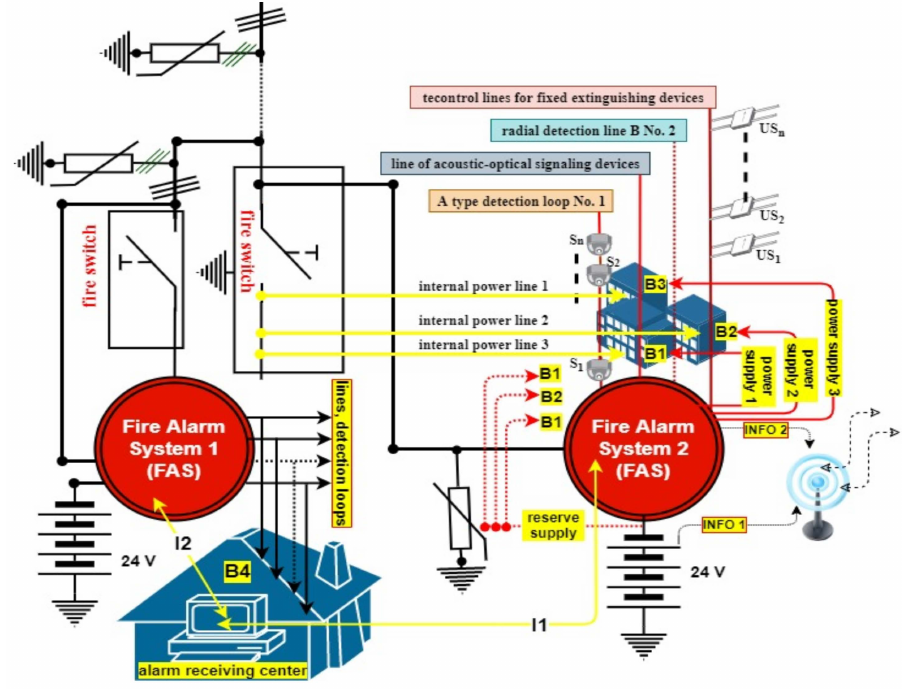
Figure 3. Power supply of fire alarm systems for B1,B2,B3—focused power supply provided by FAS2 power supply device and a 24 V battery bank for B4 building, B1,B2,B3 buildings of the